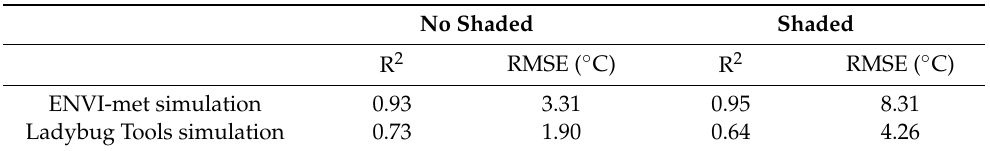
Table 3. Quantitative evaluation of the simulation’s performance for the courtyard temperature output.